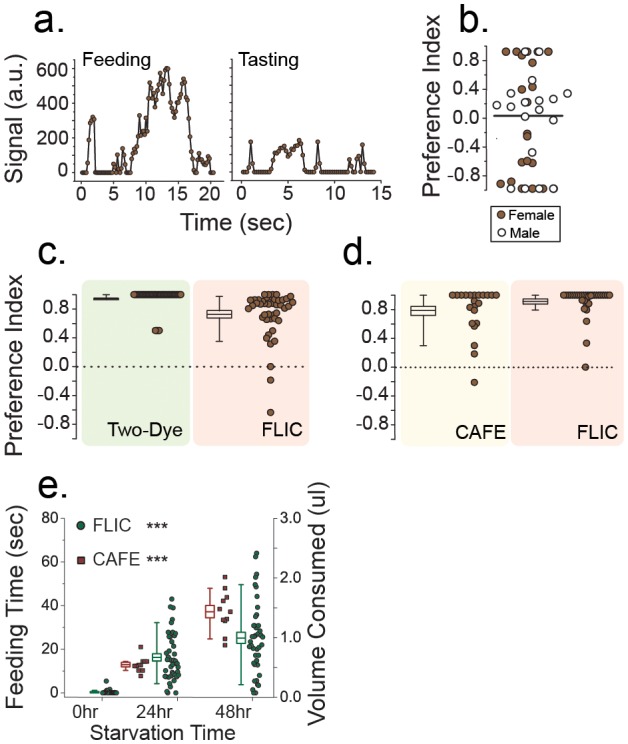
Comparison between traditional food choice assays and the FLIC system.(A) The analog signals from feeding (left) and tasting (right) behaviors have distinct characteristics. (B) When presented with identical food in both food wells, male and female flies do not exhibit a preference, which rules out systematic bias in the FLIC system (open symbol, male; closed symbol, female; pooled paired randomization test, P = 0.97). (C) Flies exhibited strong preference in favor of 10% sucrose over 100 µM denatonium when measured using both two-dye and FLIC assays (Box charts represent mean, standard error of mean, and 10–90% quantile whiskers). (D) Flies demonstrated strong preference toward 10% sucrose over 1% sucrose when measured using both the CAFE and FLIC assays (Box charts represent mean, standard error of mean, and 10–90% quantile whiskers). (E) Estimates of food consumption using the CAFE and FLIC assays. Longer starvation resulted in increased food consumption as well as total feeding time (linear regression, P<1×10−5 for both assays). Changes in food volume in the capillary tubes was undetectable when fully fed flies were used, and only FLIC data are presented for that treatment. *P≤0.05; **P≤0.01; ***P≤0.001.